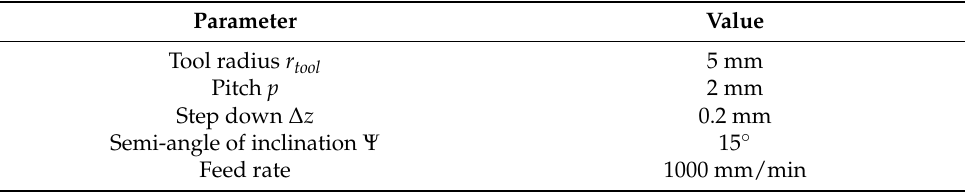
Figure 4. Schematic representation of incremental tube expansion showing ( a ) the single point hemispherical tool path and ( b ) the multi-stage forming strategy. A photograph of a specimen after eight forming stages is included in ( c ) together with a detail showing the final cracked surface. Table 1. Main parameters used in the incremental tube expansion tests.